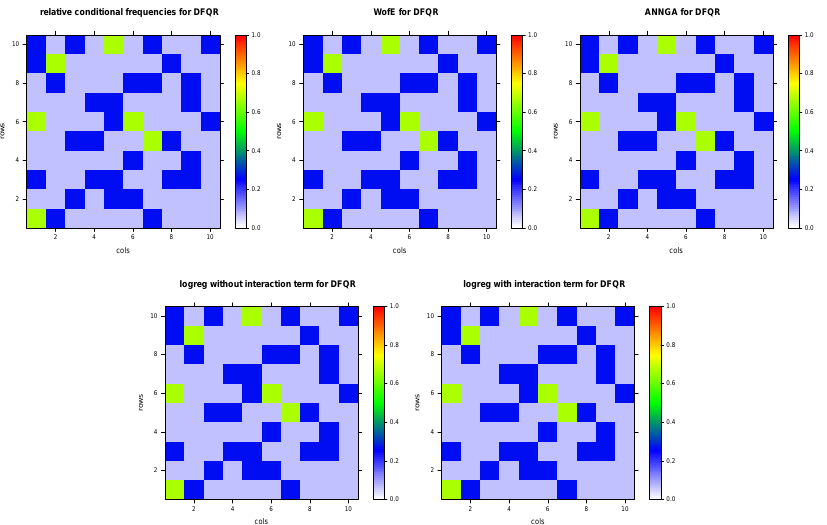
Figure 6. Spatial distribution of predicted conditional probabilities (cid:98) P ( T = 1 | B B ) for the training dataset DFQR according to: elementary estimation ( top left ); 1 2 weights-of-evidence (top center ); artificial neural net ANNGA of R ( top right ), ordinary logistic regression(bottom left), logistic regression with interaction term ( bottom right